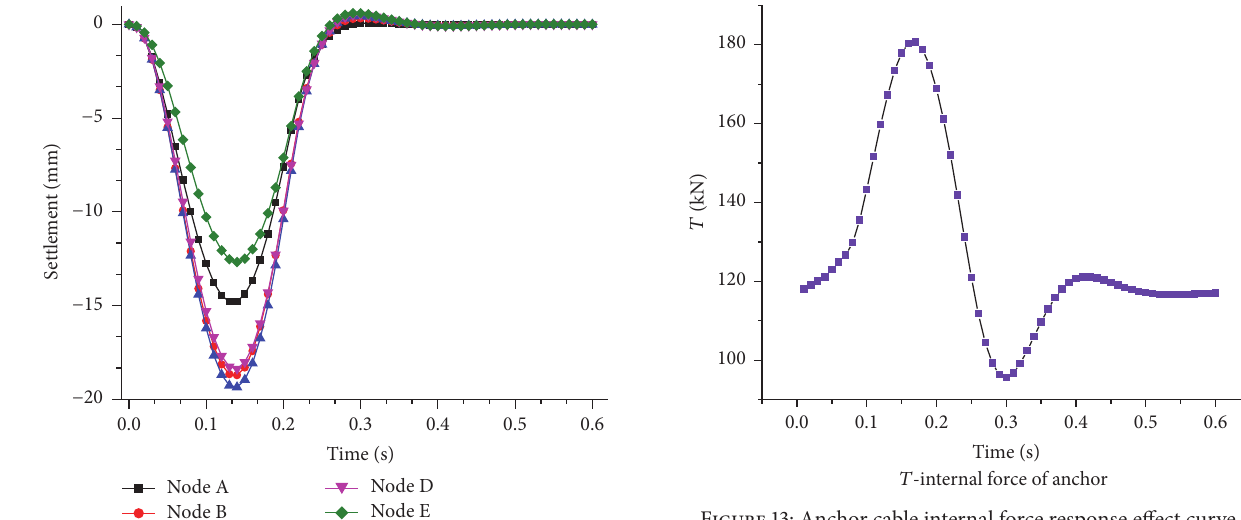
Figure 13: Anchor cable internal force response effect curve.